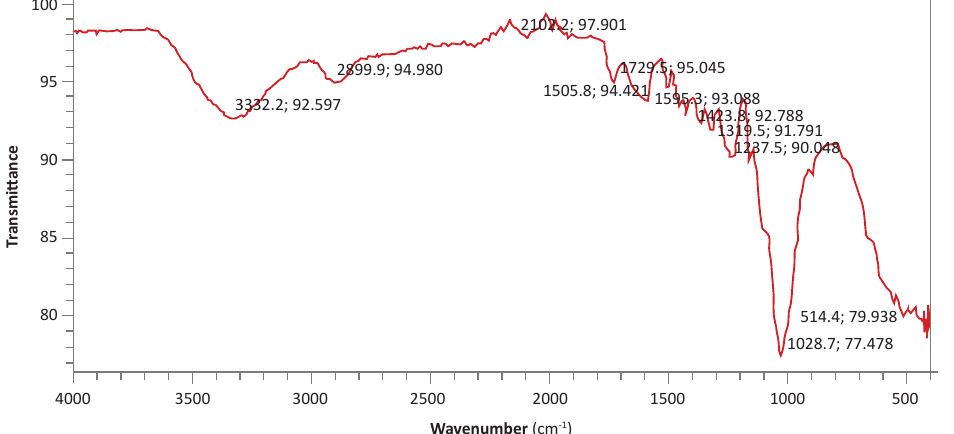
figURe 2. The FTIR spectral characteristics of poplar sawdust.